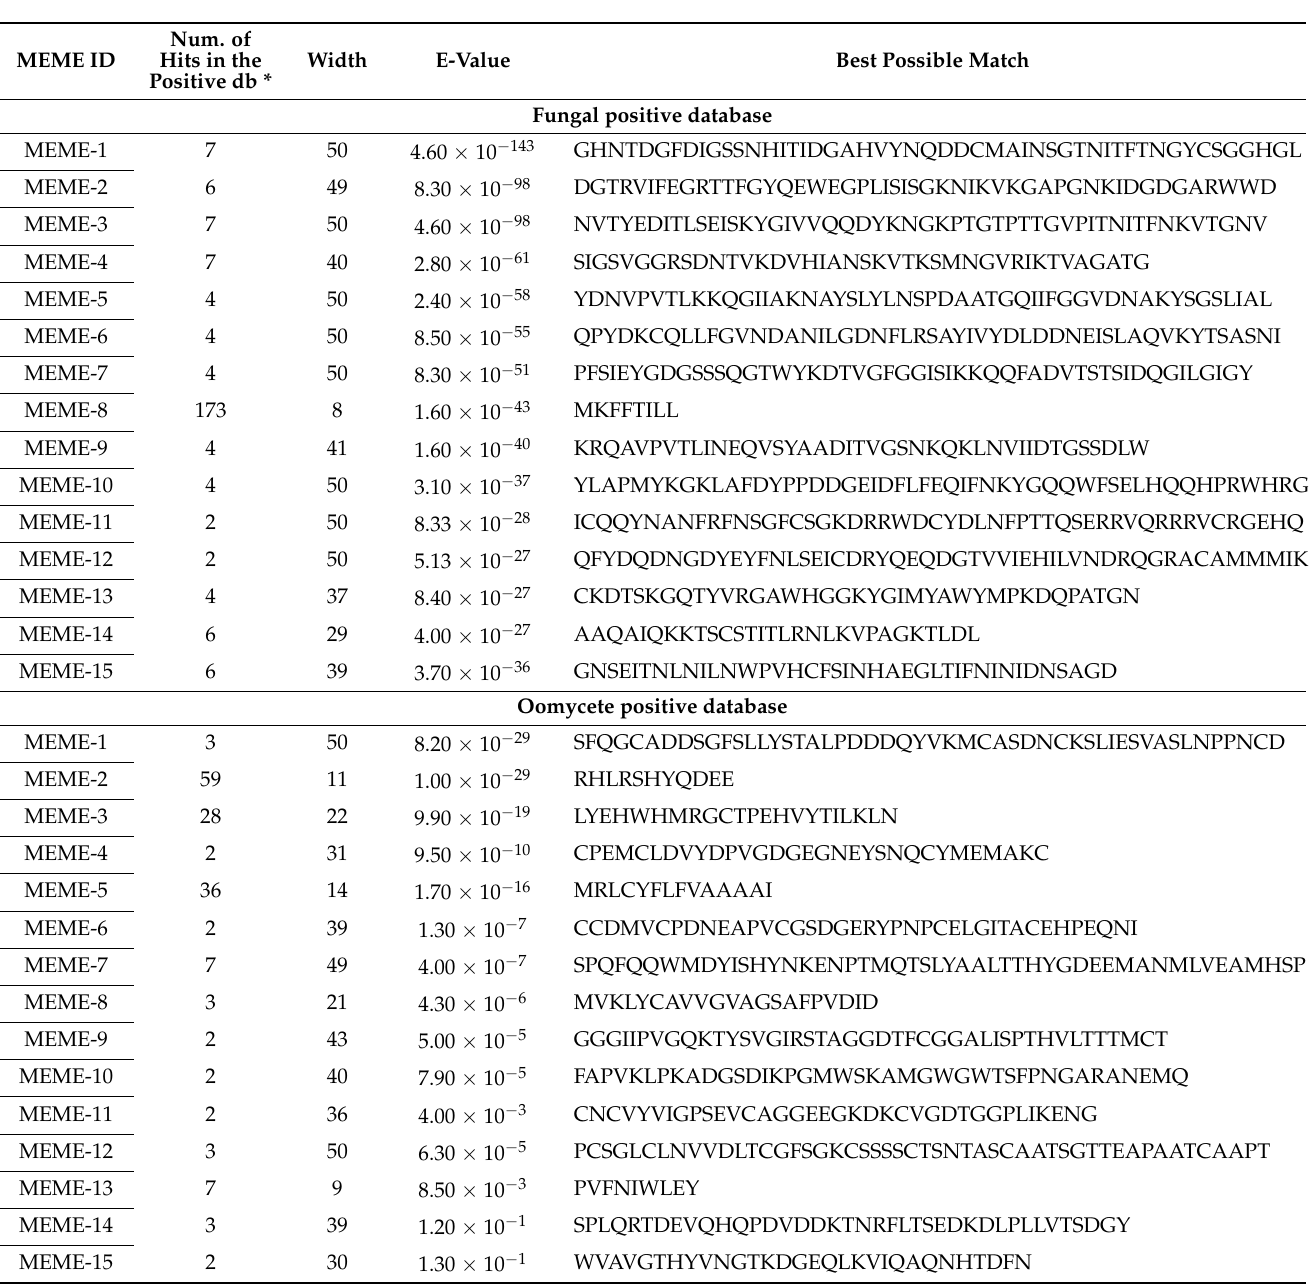
Table 6. Sequence motifs found in fungal and oomycete true effectors. Top15 MEME motifs found in true, validated fungal and oomycete